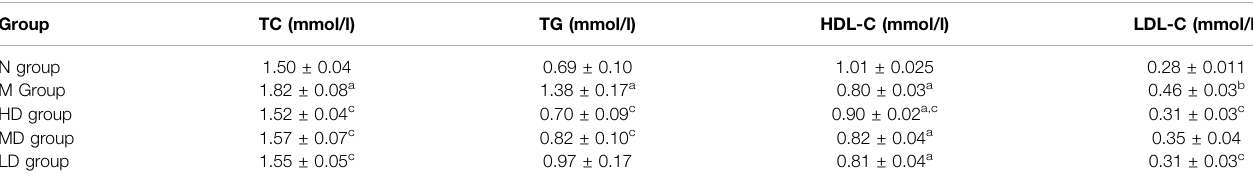
TABLE 1 | Effects of CQR on serum biochemical parameters in obese rats.